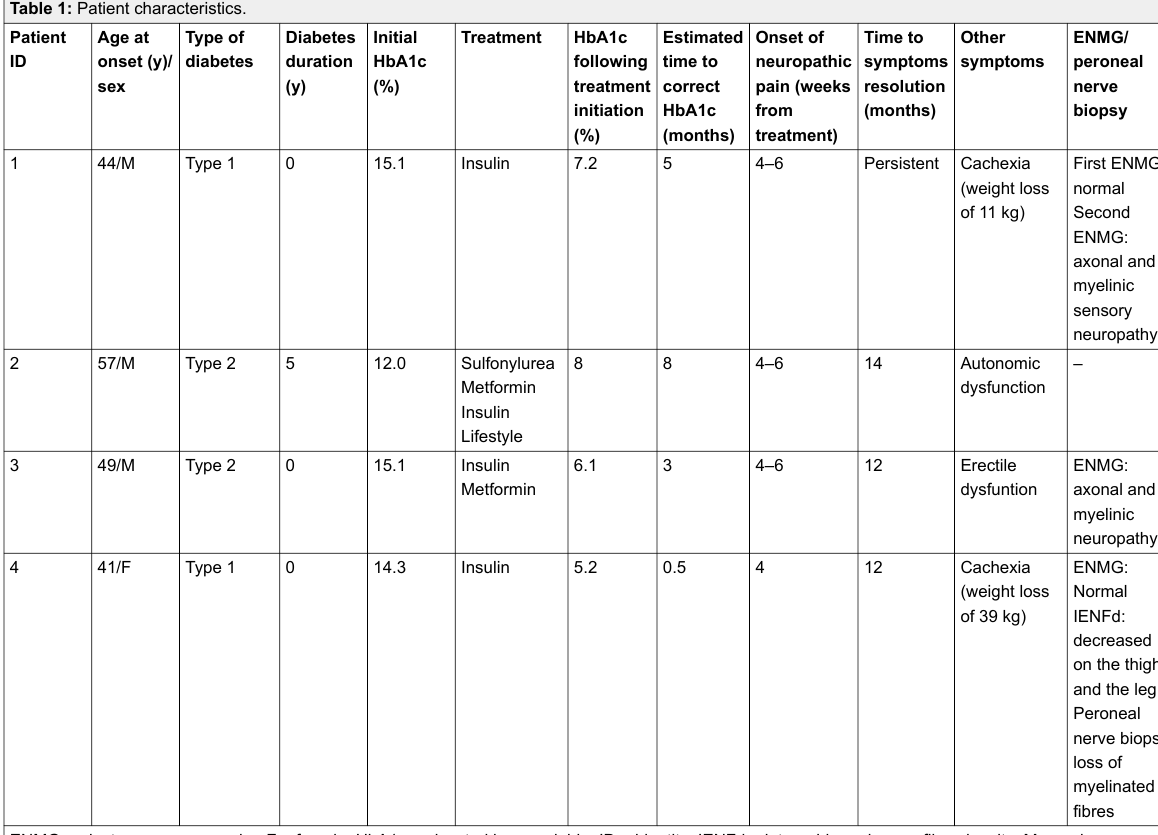
Table 1: Patient characteristics.